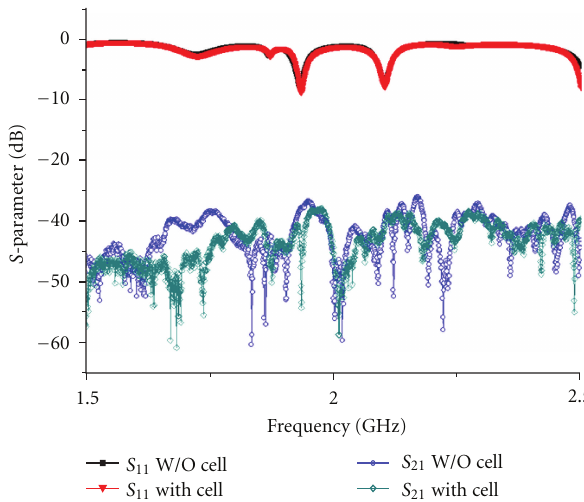
Figure 10: Measured return loss and isolation characteristics of two-by-two microstrip patch array